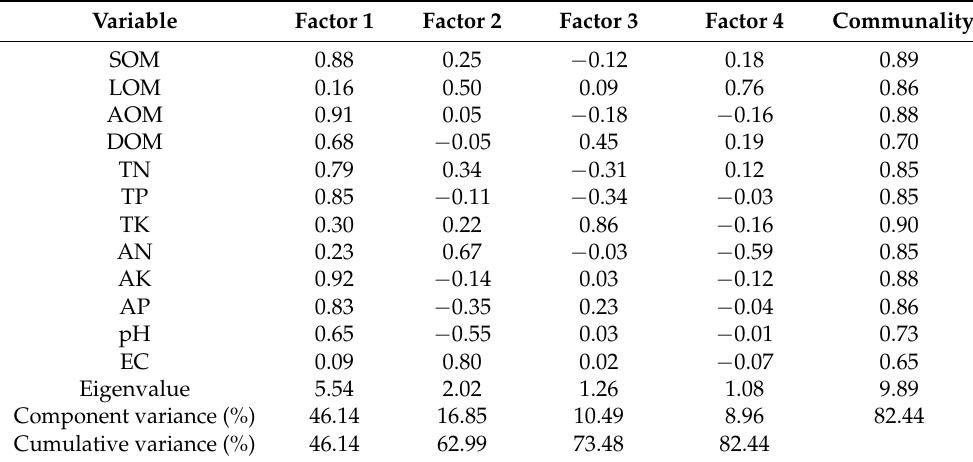
Table 3. Variable loading coefficients of the first three factors extracted using soil properties and communality in 2022.